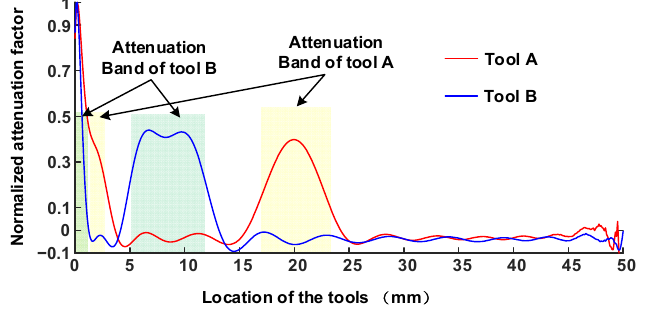
Figure 4. Normalized vibration amplitude attenuation factors of Tool A and Tool B.